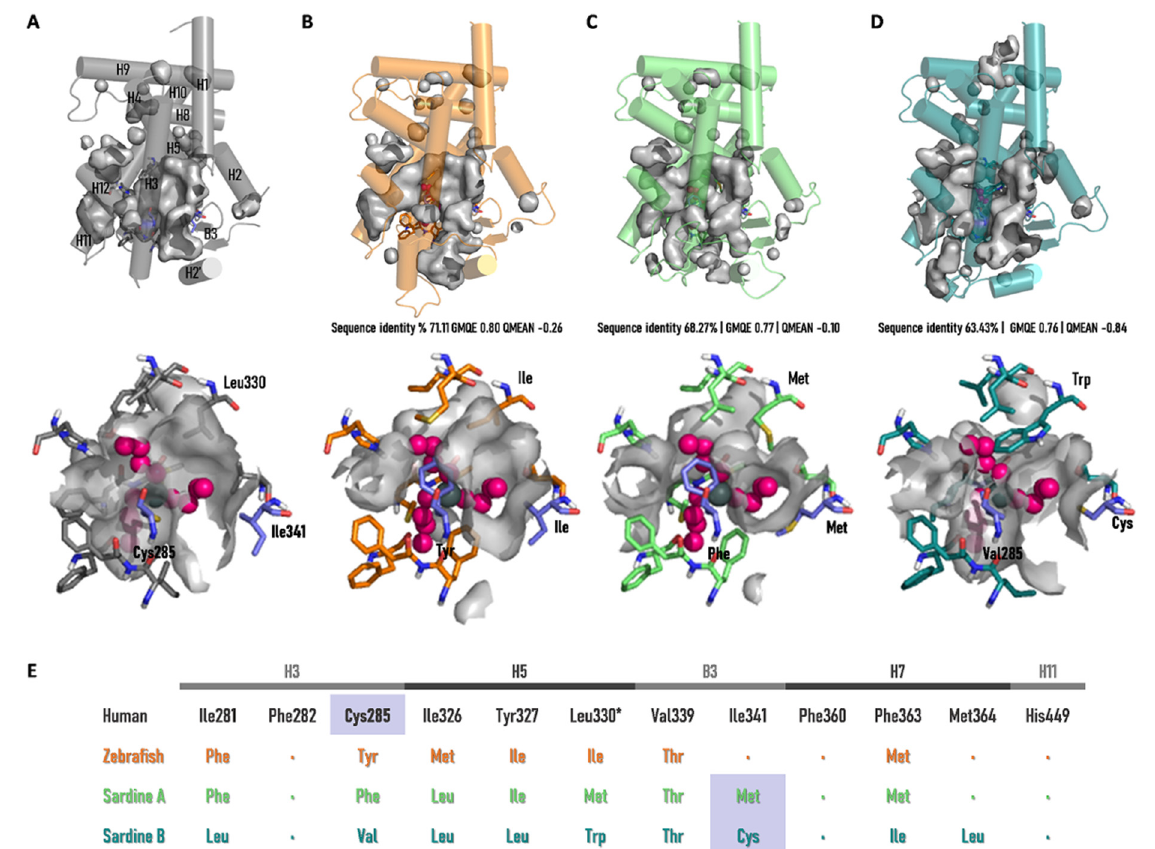
Figure 5. PPAR γ ligand-binding pocket (LBP) cavities analysis. ( A ) Human PPAR γ ligand-binding domain (LBD) crystal structure 3WJ4 with representation of LBD cavities (top), and detailed view of the LBP cavity with the residues that interact with TBT (Harada et al. 2015 [45]) depicted as sticks (down). ( B–D ) Zebrafish PPAR γ , sardine PPAR γ A and sardine PPAR γ B homology models with representation of LBD cavities (top), and detailed view of the LBP cavities with the corresponding interacting residues depicted as sticks (down). TBT molecule from crystal structure 3WJ4 is shown in magenta. Sequence identity (%), global model quality estimation (GMQE), QMean are indicated below each model. ( E ) Human PPAR γ residues that interact with TBT and the corresponding residues found in Zebrafish PPAR γ , sardine PPAR γ A and sardine PPAR γ B. The location of the residues in the structure is indicated (H, helix; B, β -strand). * Indicates a residue substitution in sardine PPAR γ B, resulting in an aromatic ring protrusion.